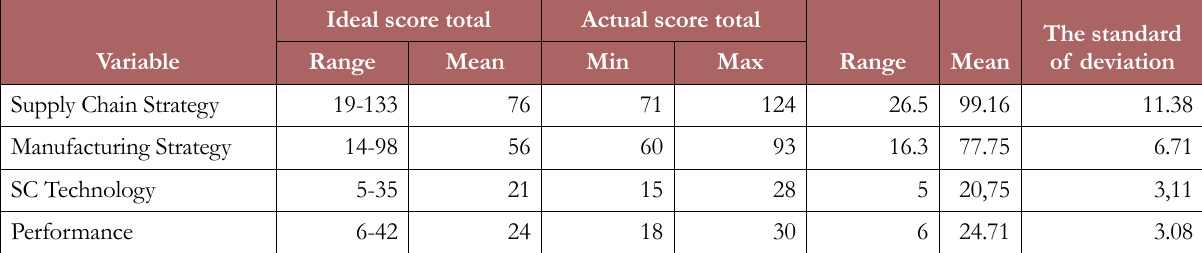
Table 4. The summary of ideal score total versus real total score